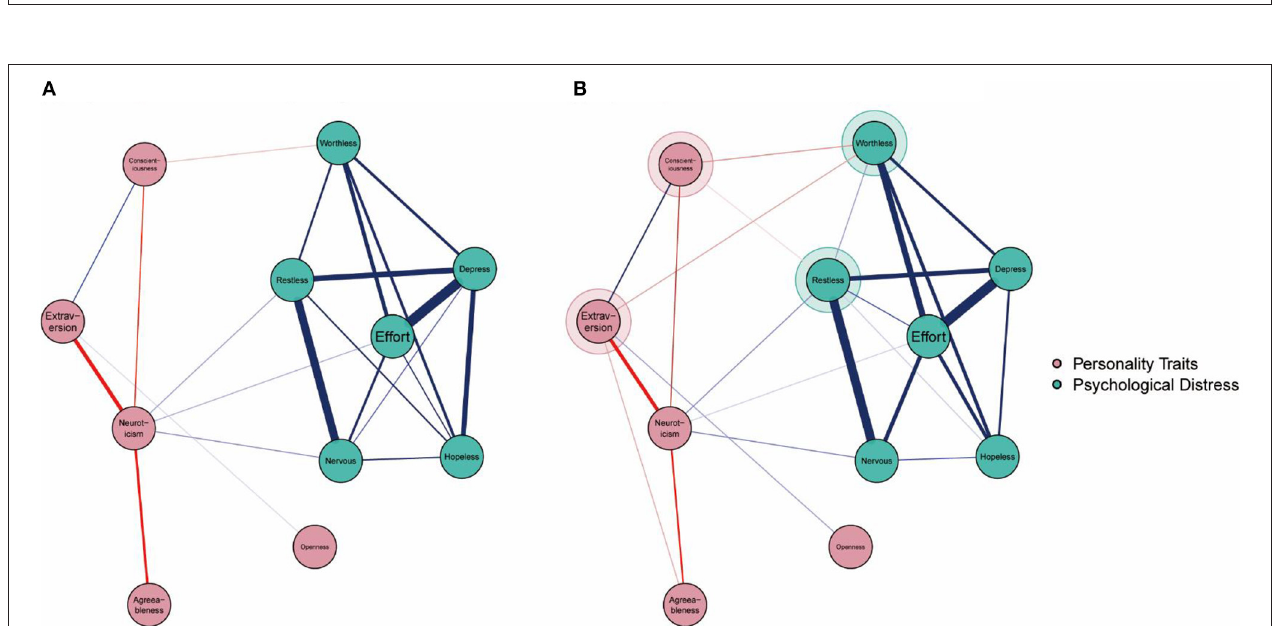
FIGURE 2 | Graphical results of the estimated network models without control variables during college lockdown and after college lockdown. Blue links denote positive associations and red links denote negative associations. The color borders highlighted for nodes in (B) denote new links compared to the (A) .